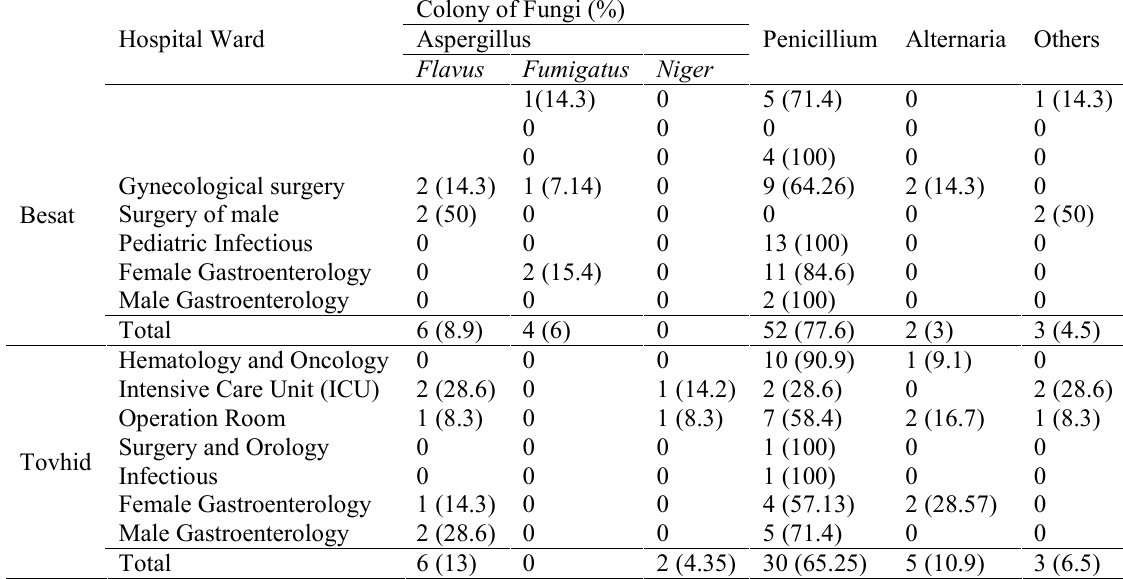
Table 2. Number of fungal colonies and species in the air sampled from various wards